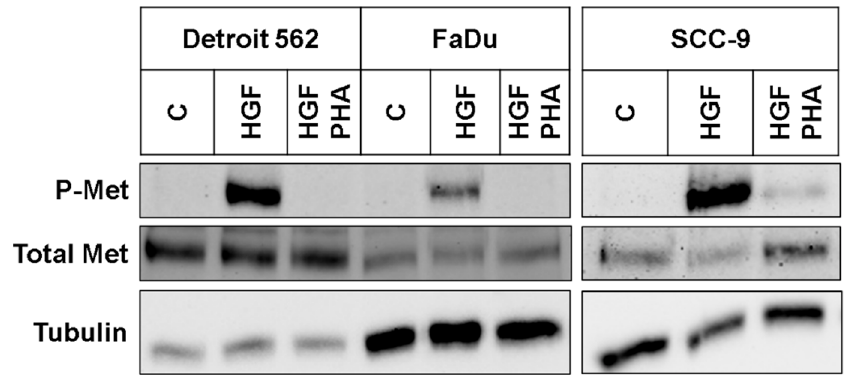
Figure 1. Hepatocyte growth factor (HGF) activates the Met receptor on the investigated cell lines. Results of immunoblotting using an antibody recognizing Met receptors phosphorylated at Tyr1234/Tyr1235 (P-Met). Cells were treated for 30 min with 50 ng/mL HGF (HGF), HGF plus 50 µM PHA-665752 (HGF PHA), or neither (C). Blots were stripped and reprobed using a Met-specific antibody recognizing total Met. As a loading control, lower parts of the blots were incubated with an antibody recognizing tubulin. SCC-9 samples were loaded onto a separate gel. A typical experiment out of three is shown.